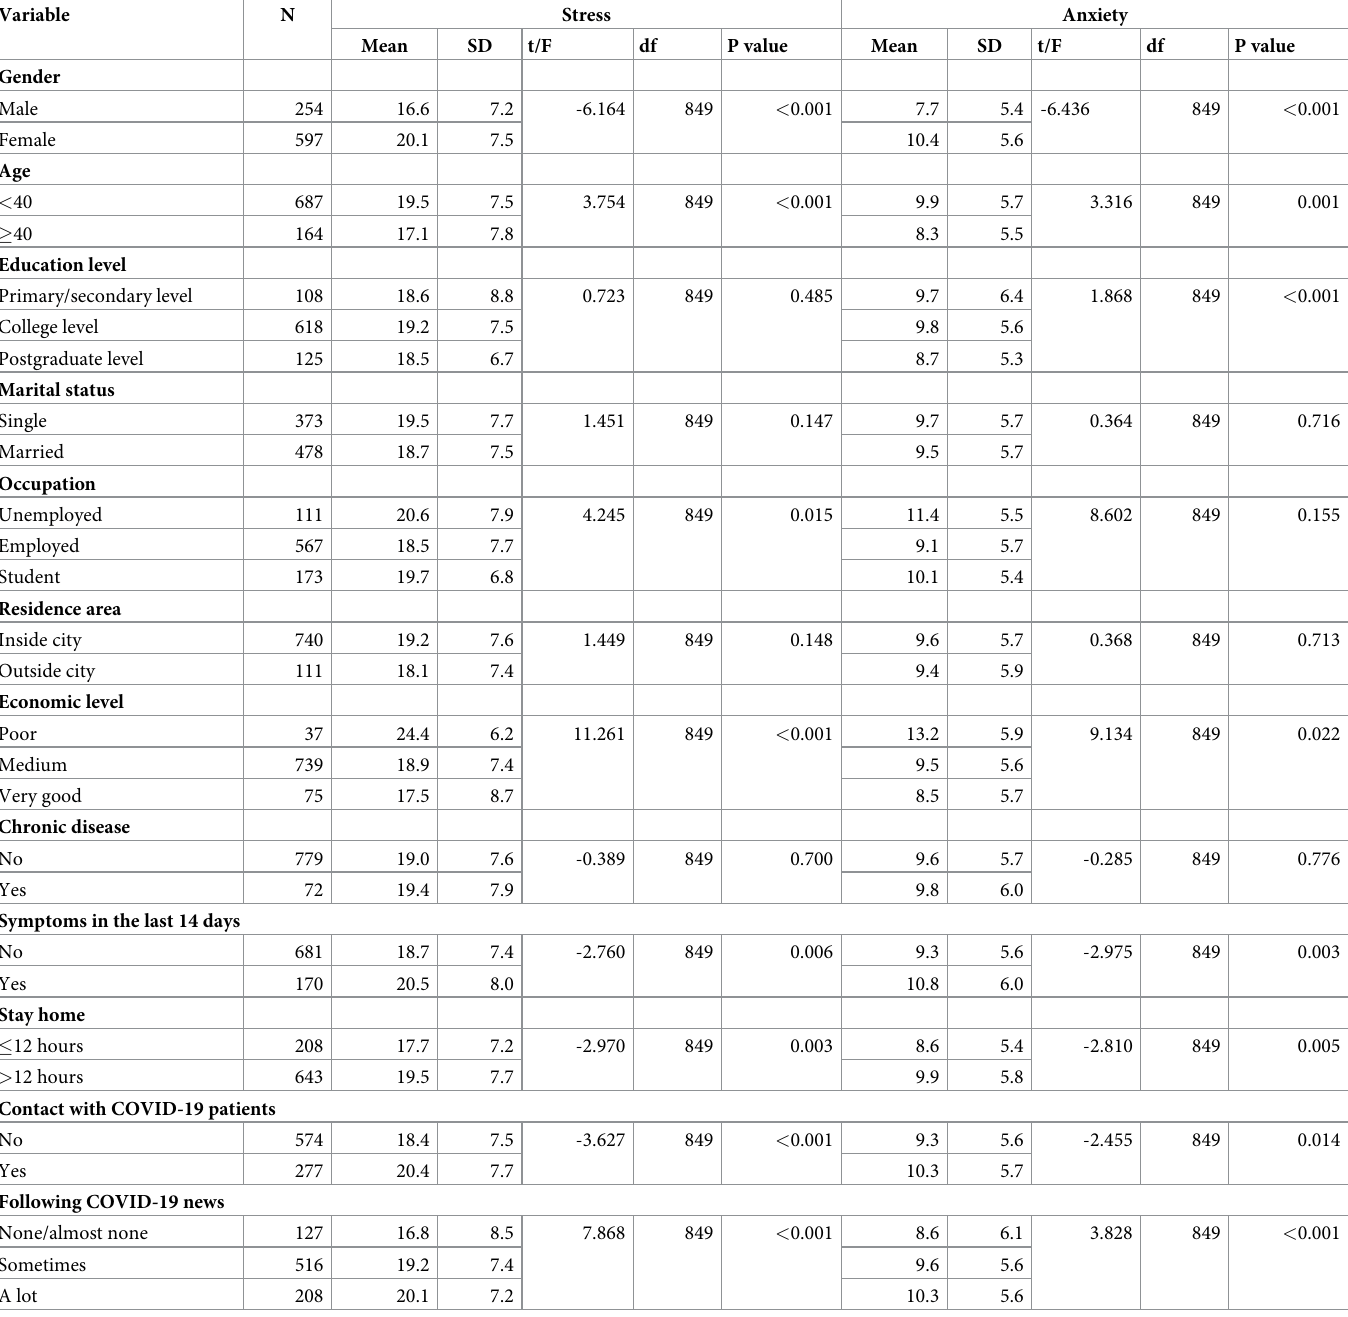
Table 3. Factors associated with self-perceived stress and anxiety in the